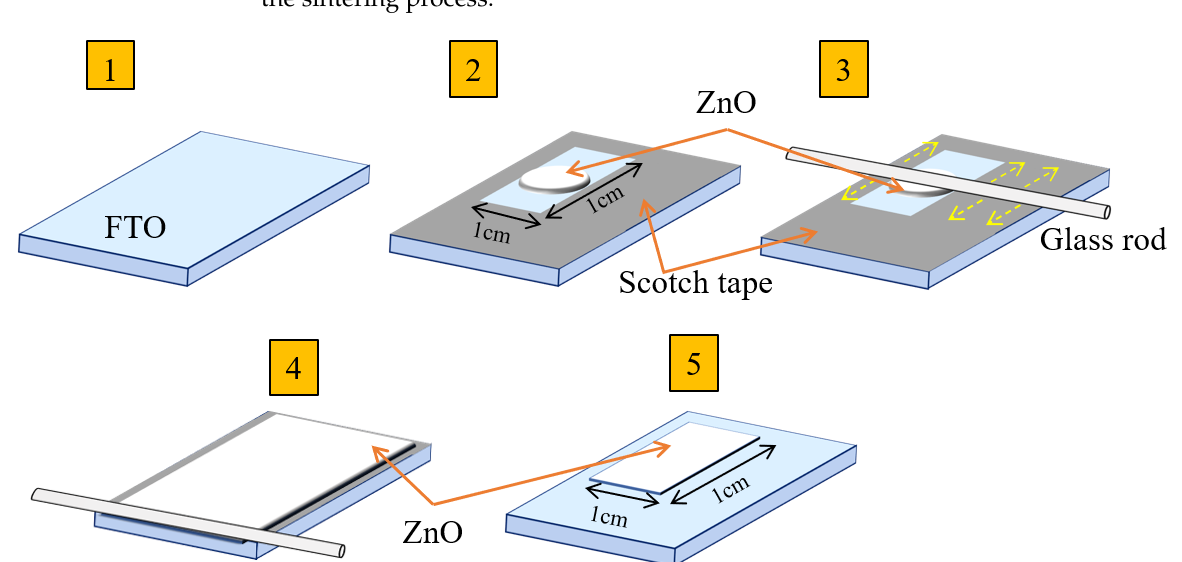
Figure 1. ZnO paste application by doctor blade